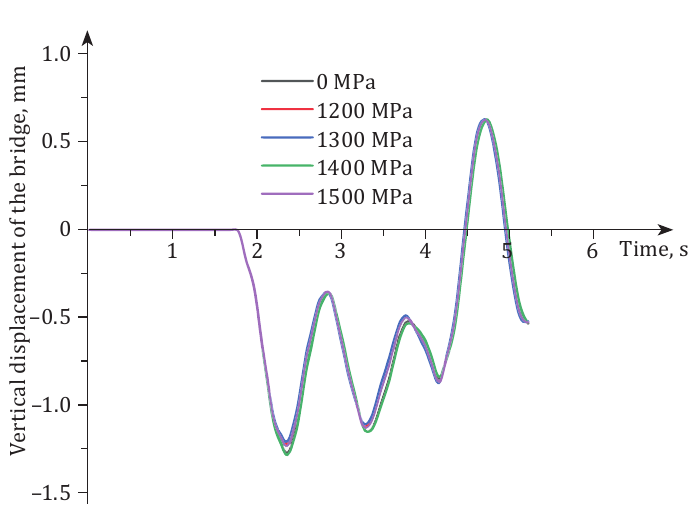
Figure 16. Comparison of vertical displacement time history at bridge midspan